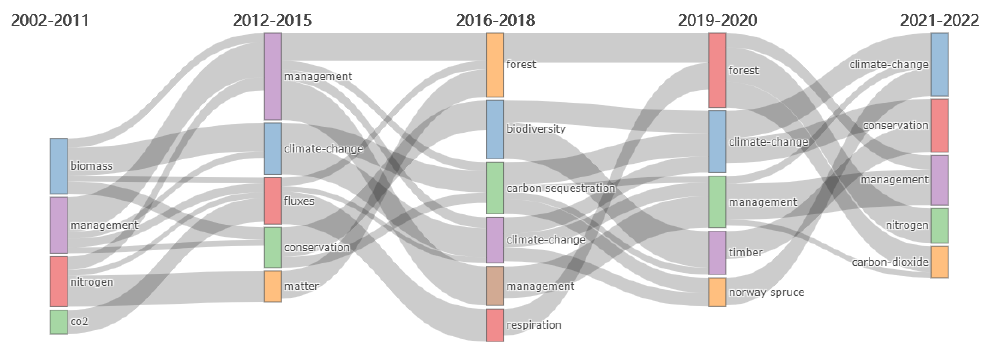
Figure 9. Theme Evolution Chart.